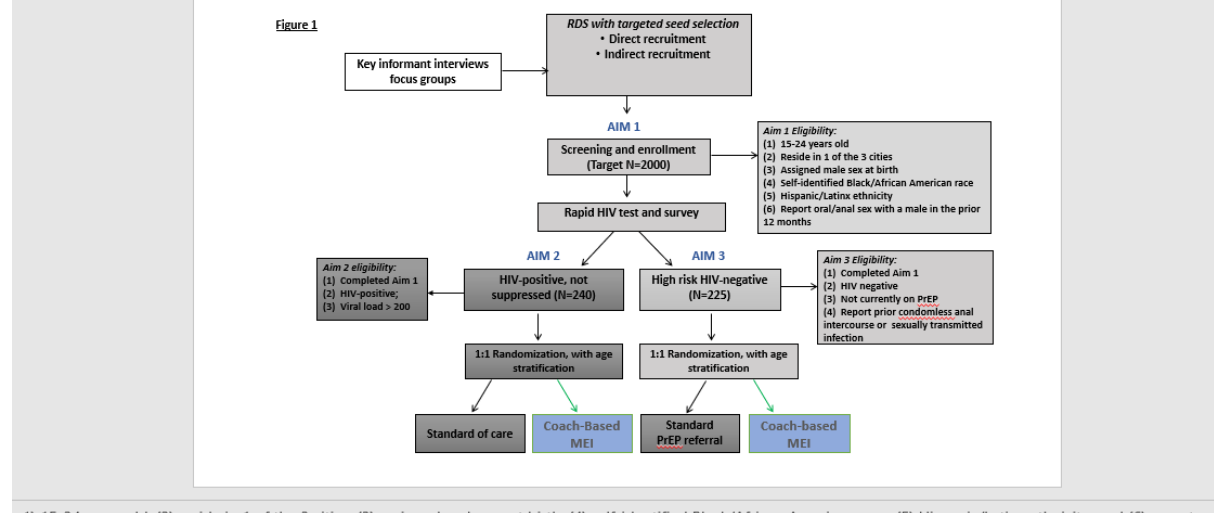
Figure 1. Study flow diagram. MEI: mobile-enhanced intervention; PrEP: pre-exposure prophylaxis; RDS: respondent-driven